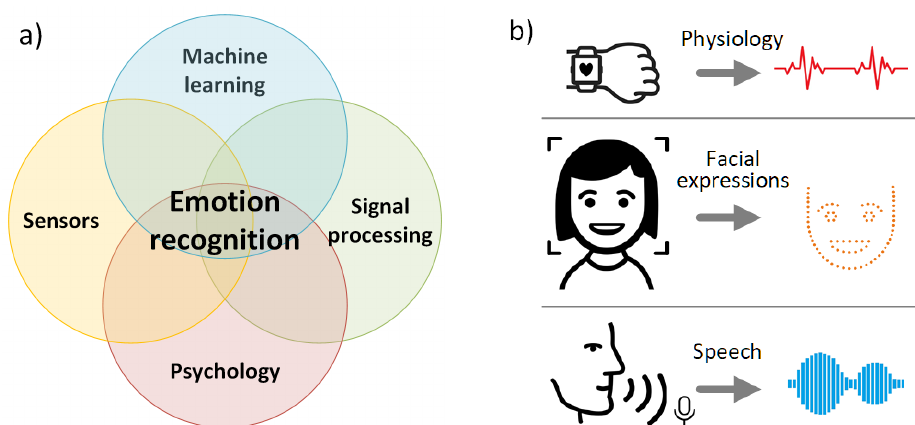
Figure 1. ( a ) The interdisciplinary background of emotion recognition; ( b )modalities used to recognize